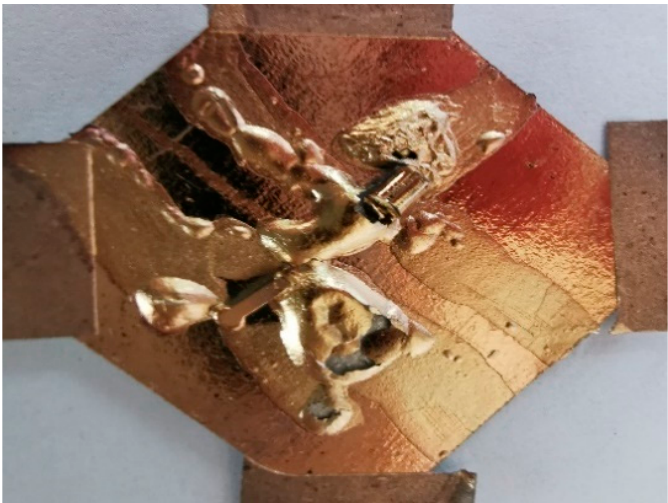
Figure 2. Samples ready for scanning.